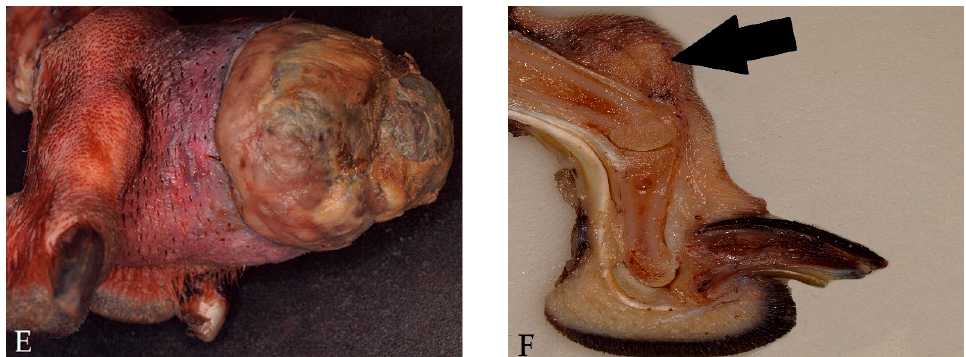
Figure 3. Gross pictures of various pathological lesions in canine toes. (( A , C ) preoperative clinical pictures; ( B , D , F ) longitudinal cut, formalin fixed material; ( E ) formalin fixed amputated digits.) ( A ) Severe pyogranulomatous dermatitis with hair fragments and osteomyelitis of the nail beds of a 5- year-old Great Dane; ( B ) subungual keratoacanthoma of a 13-year-old Cavalier King Charles Spaniel; ( C ) squamous cell carcinoma (diameter 0.9 cm) of a Schnauzer with claw loss and osteolysis; ( D ) acral malignant melanoma (diameter 1.6 cm) of an 11-year-old Labrador Retriever; ( E ) ulcerated neurofibroma (diameter 3.0 cm) between two toes of a 13-year-old Mongrel; ( F ) Cutaneous mast cell tumor (arrow) in a 6-year-old German Shepherd dog.